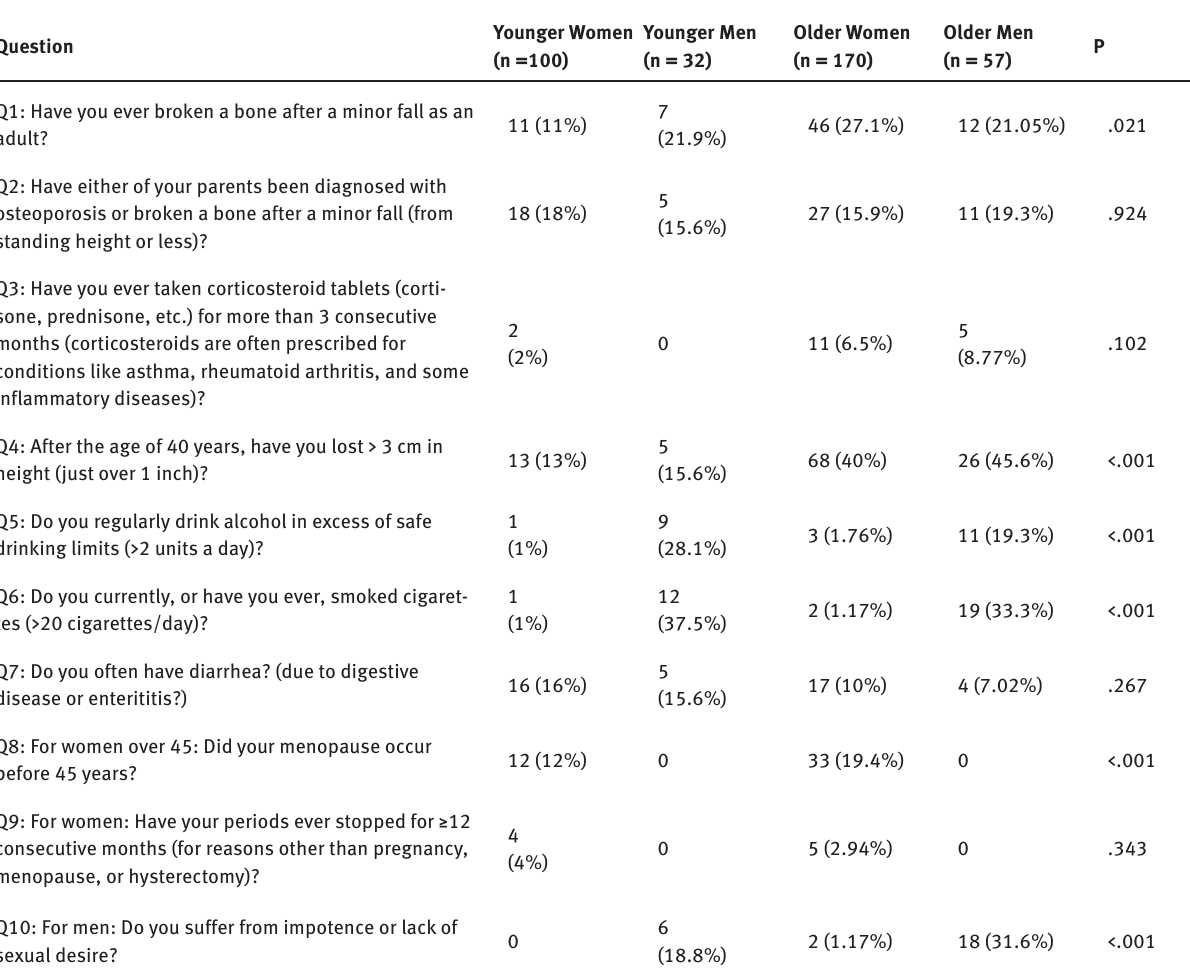
Table 2: Positive Answers to the IOF Test among the Four Groups